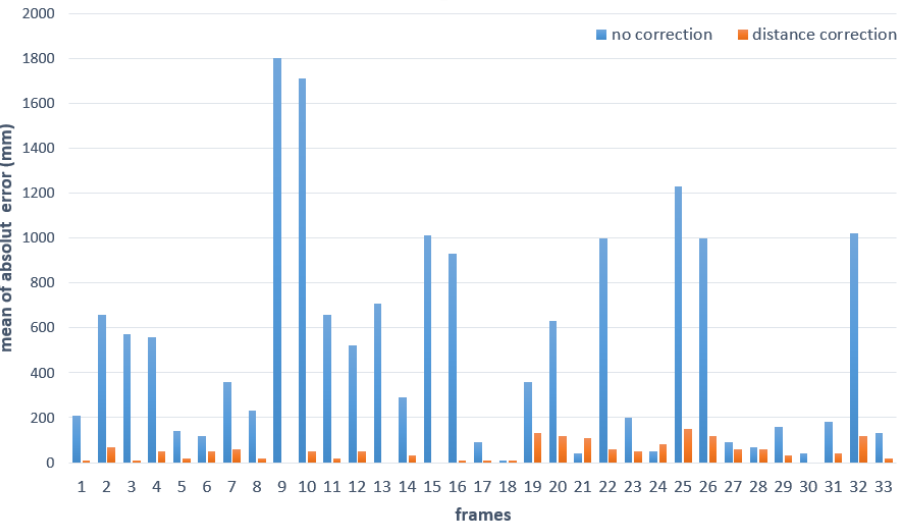
Figure 18. Distance error with and without correction.